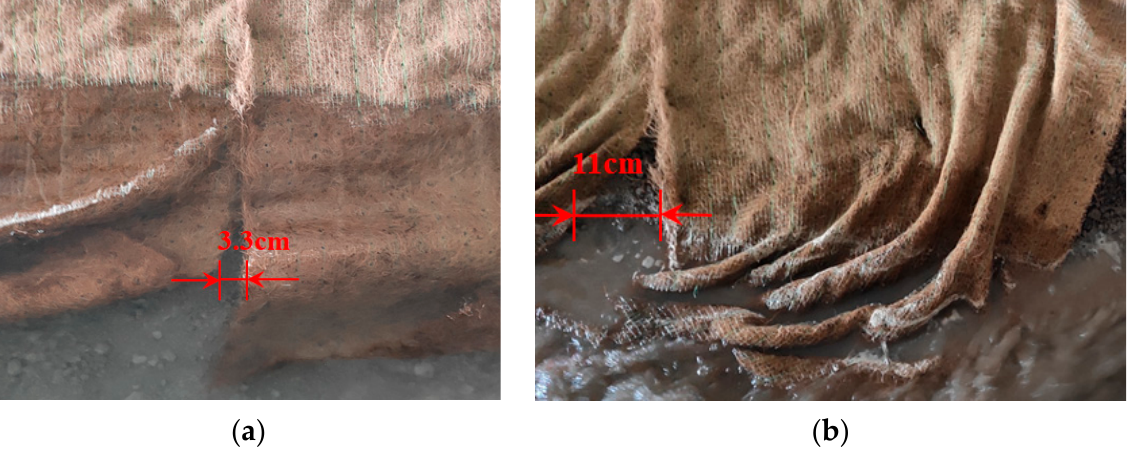
Figure 8. Damage types of vegetation grass mat material: ( a ) ejection of fixed steel nails (RUN 8, after 2 h scouring); ( b ) material floating (RUN 8, after 2.25 h scouring).